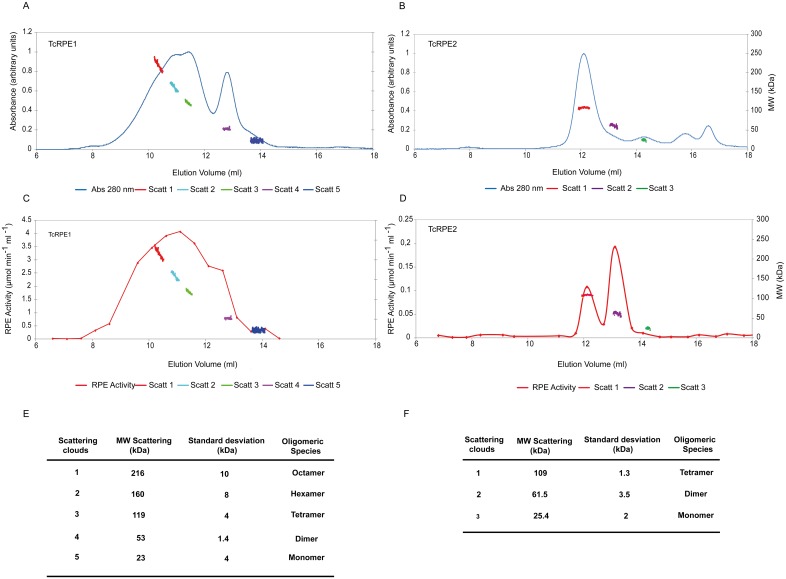
Each TcRPE displays a complex oligomeric composition.Panels A, C and B, D correspond to TcRPE1 and TcRPE2, respectively. Absorbance at 280 (thin blue line), molecular mass in kDa estimated by LS (clouds points of different color) and RPE activity (thin red line). Panels E and F summarize in tabular form the different oligomeric states found for TcRPE1 and TcRPE2, respectively.